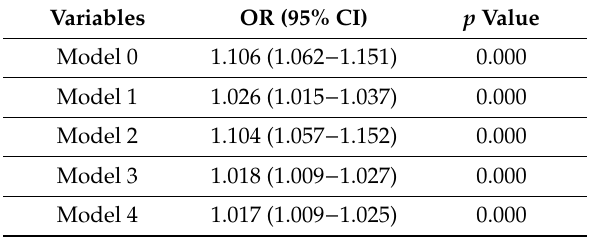
Table 2. Association between plasma Gal-3 levels and clinical variables of